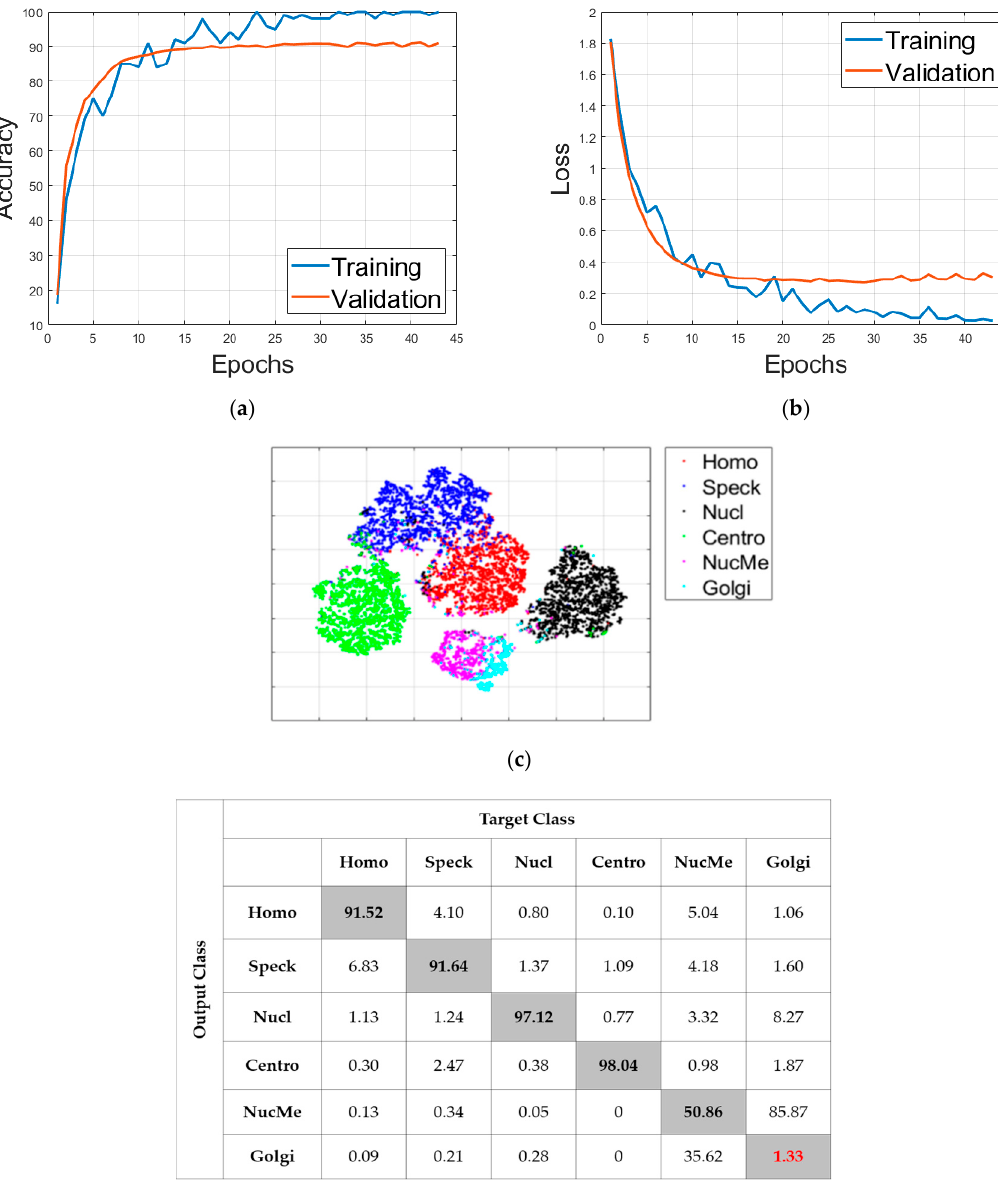
Figure 13. Classification results of the “IN_RS” case: ( a ) accuracy, ( b ) loss, ( c ) features’ visualization and ( d ) confusion